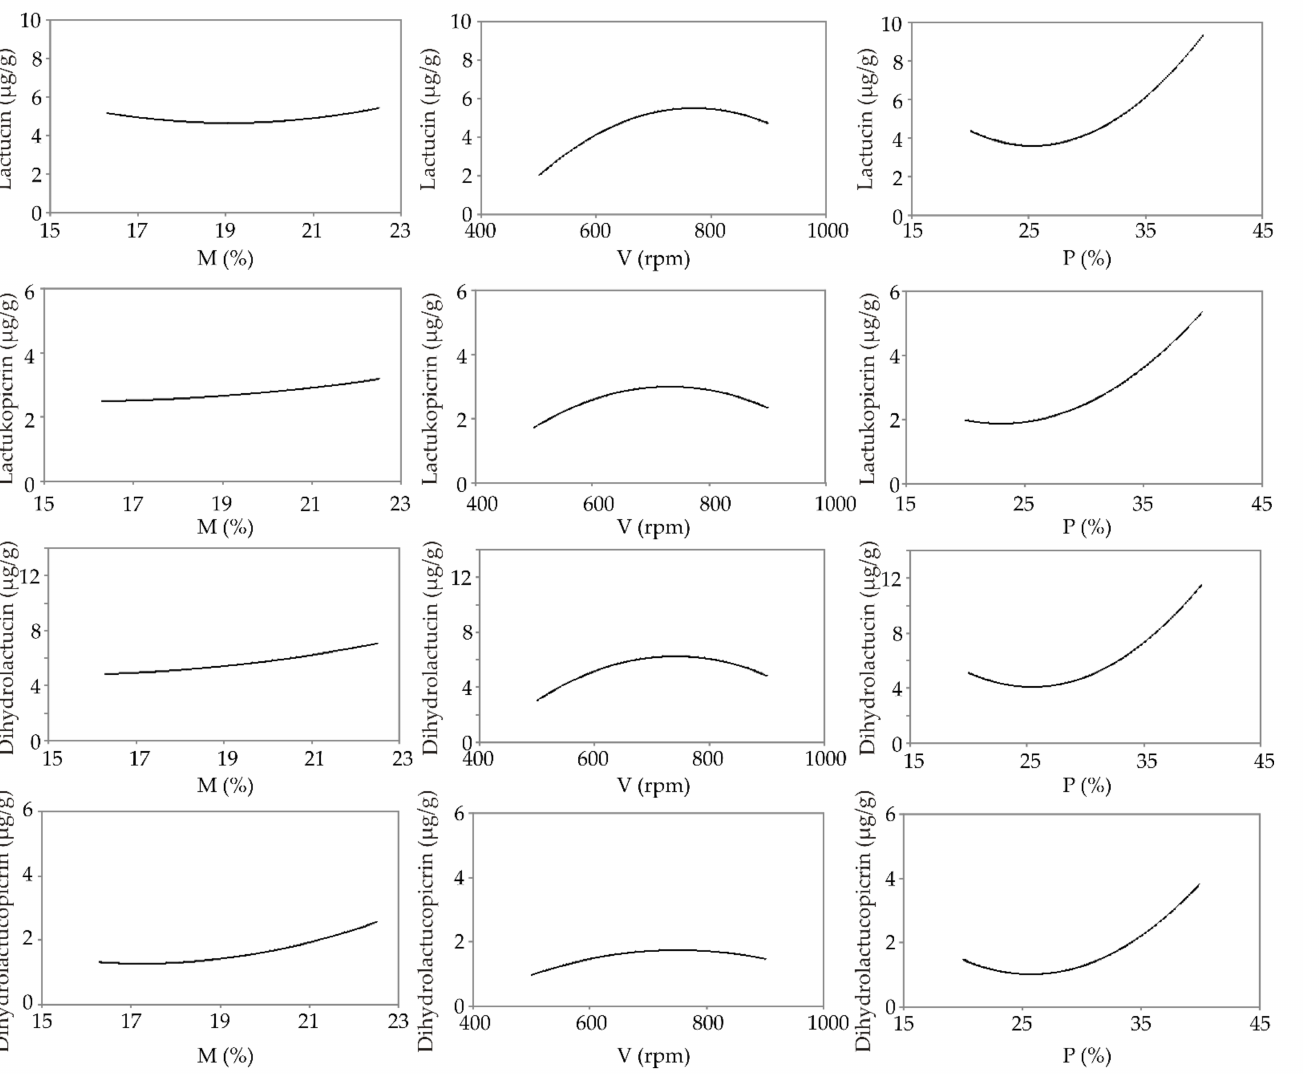
Figure 2. Influence of extrusion conditions (M—moisture content; V—screw speed; P—chicory root content) on sesquiterpene lactones